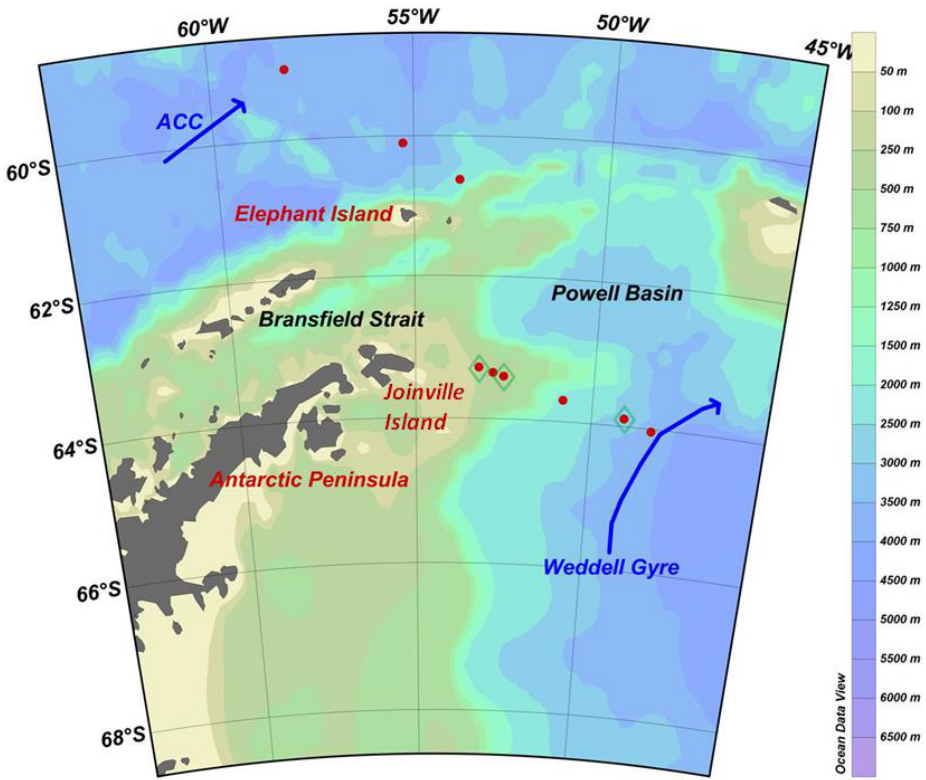
Fig. 1b. Overview of Peninsula region at expanded regional scale. Sample stations are indicated with red dots; green diamonds mark stations with less than five samples, whereas regular stations have 24 samples. Flow directions of Weddell Gyre and ACC are indicated schematically with blue